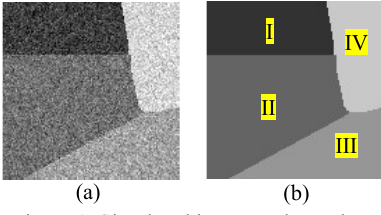
Figure 1. Simulated image and template.